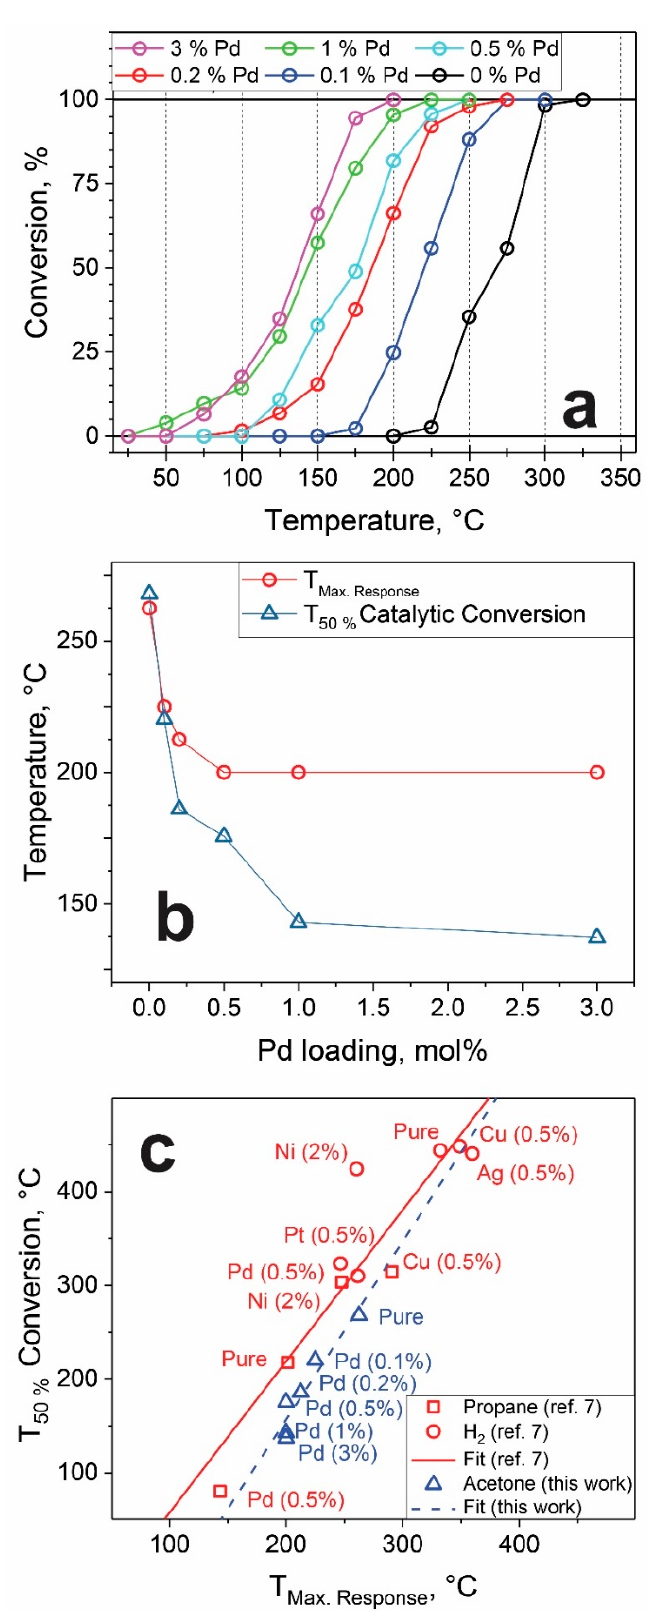
Figure 4. ( a ) Conversion of 1 ppm acetone; ( b ) Temperature of max. response and 50% catalytic conversion as a function of Pd loading; ( c ) Comparison of T 50% conversion and T Max. Response by [7] and this work.